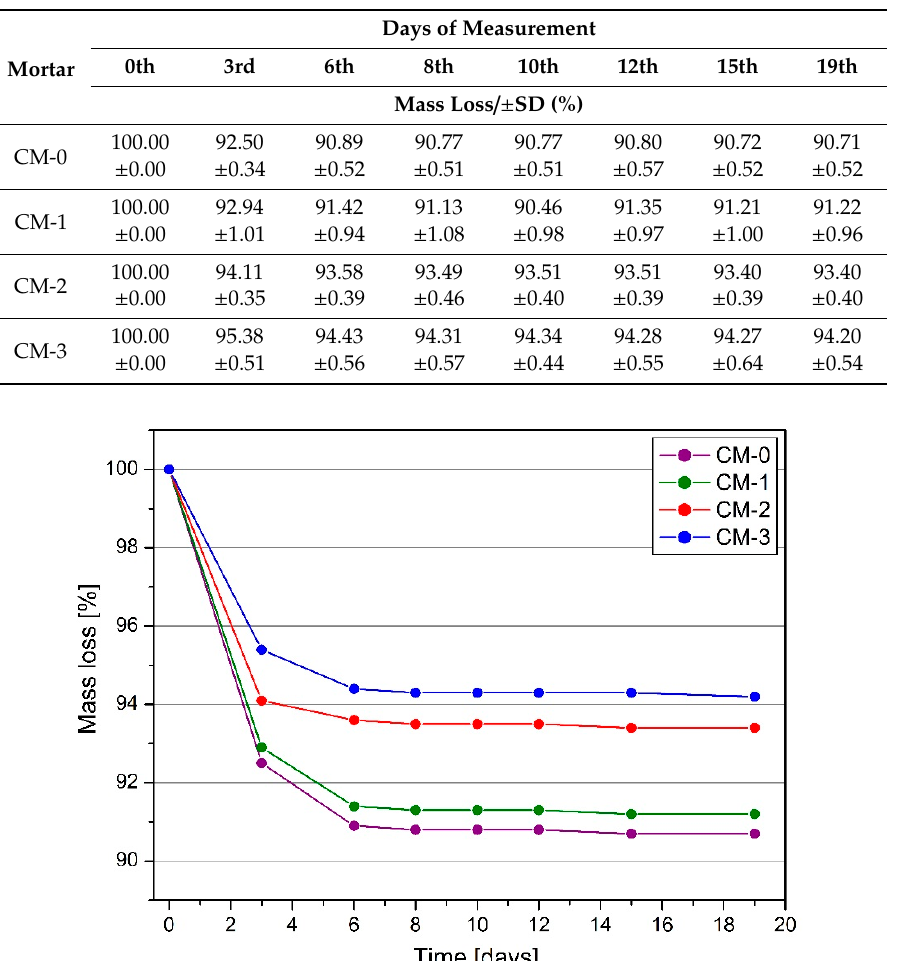
Figure 7. The average decrease in sample mass on individual days.